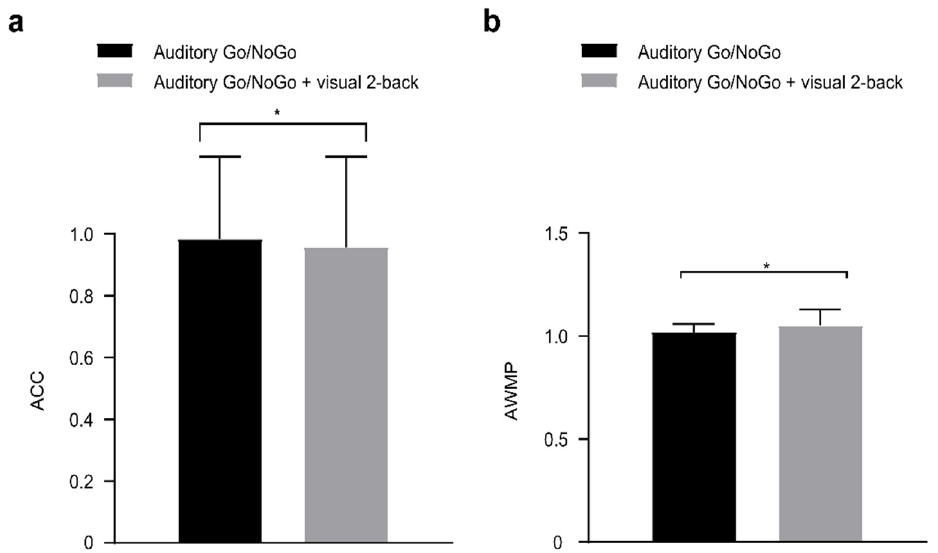
Figure 5. In the visual 2-back interference condition, ( a ) single-task (auditory) and dual-task (audiovisual interaction) groups for accuracy (ACC); ( b ) single-task (auditory) and du-al-task (audiovisual interaction) groups for performance data (auditory working memory performance, AWMP). Between the single auditory Go/NoGo task and the dual auditory Go/NoGo + visual n-back task revealed significant differences, p < 0.05. All the data are presented as the mean ± S.D ( n = 44); * p < 0.05.